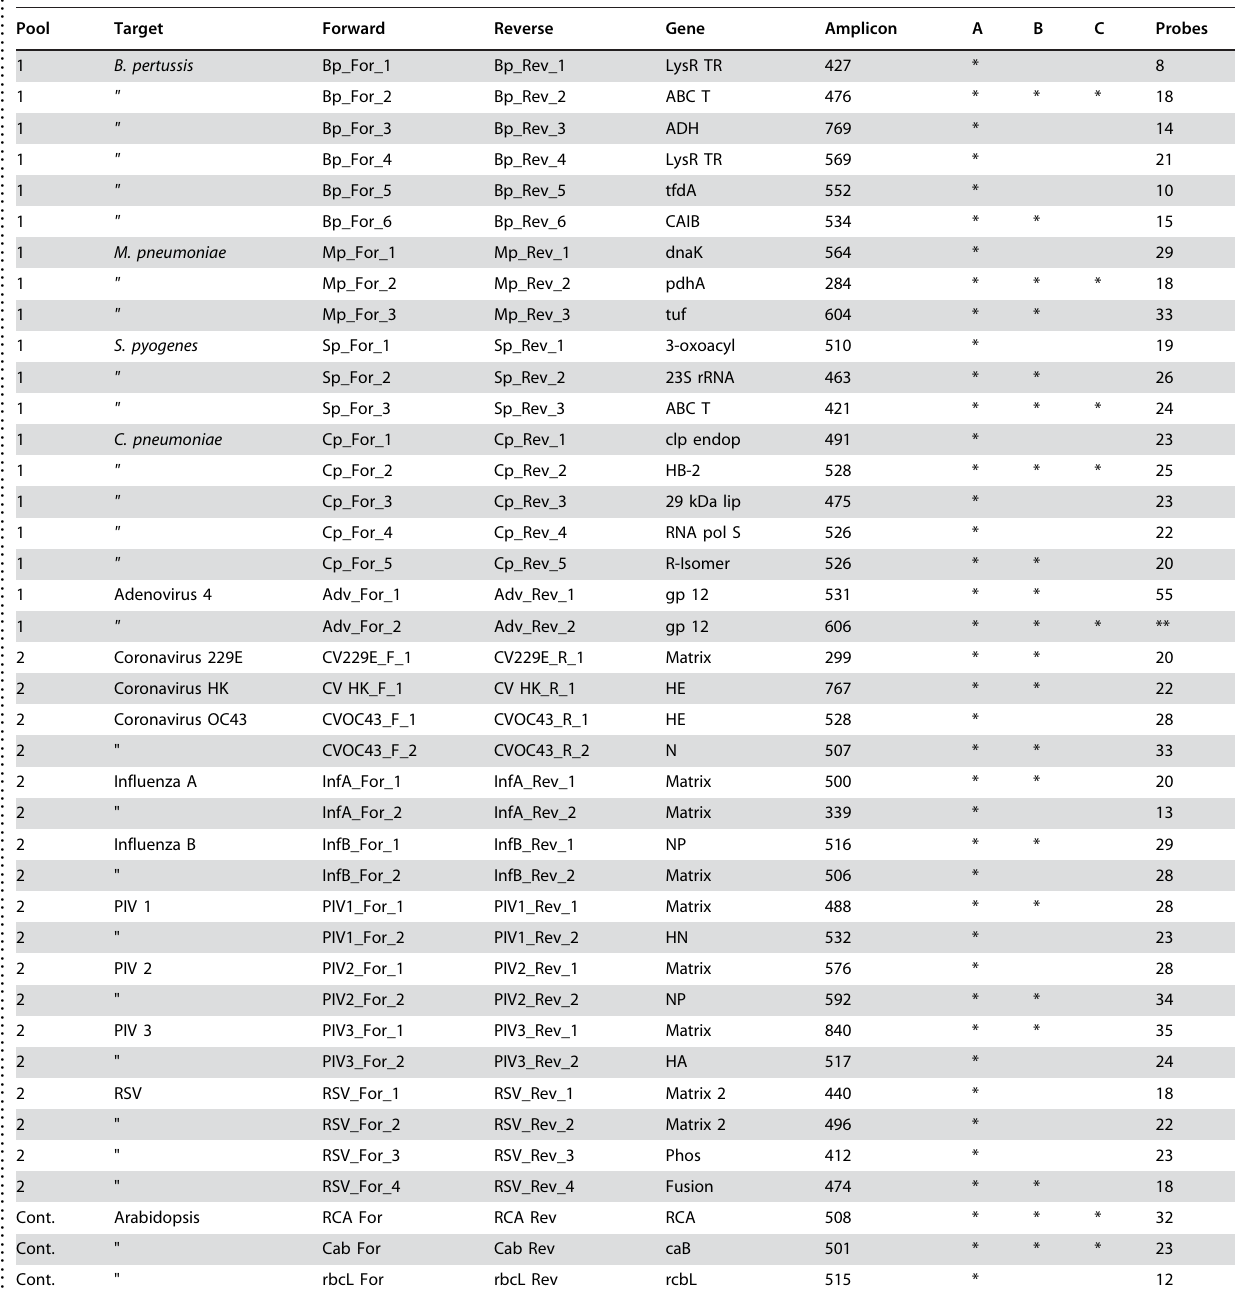
Table 1. Primer pools, amplicons and probes for the URI assay. .. ... .... ... ... .... ... ... .... ... ... .... ... ... .... ... ... .... ... ... .... ... ... .... ... ... .... ... ... .... ... ... .... ... ... .... ... ... .... ... ... .... ... ... . Pool